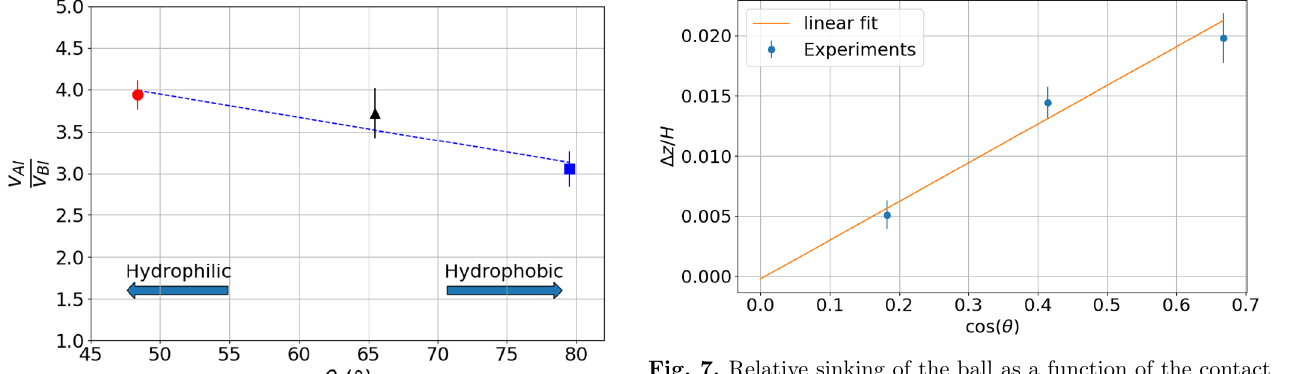
Fig. 7. Relative sinking of the ball as a function of the contact angle for a given initial drop height, H = 66 cm.